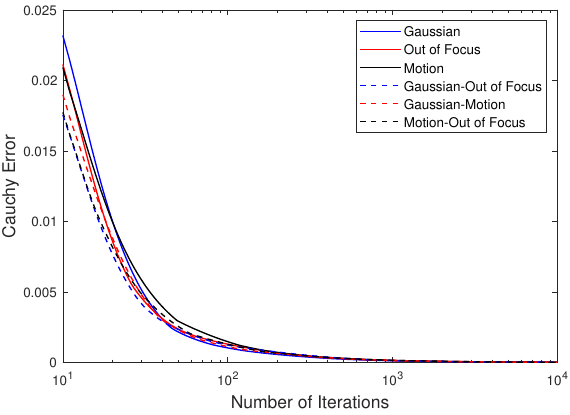
Figure 30. Cauchy error plots of the proposed algorithm in all cases of grey